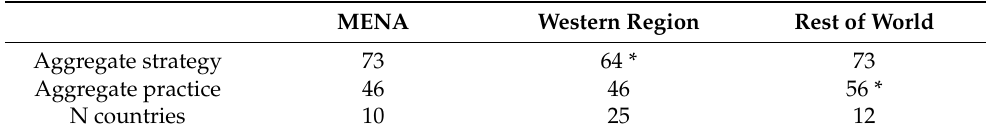
Table 5. Aggregate strategy and aggregate practice in MENA, western region, and rest of the world (47